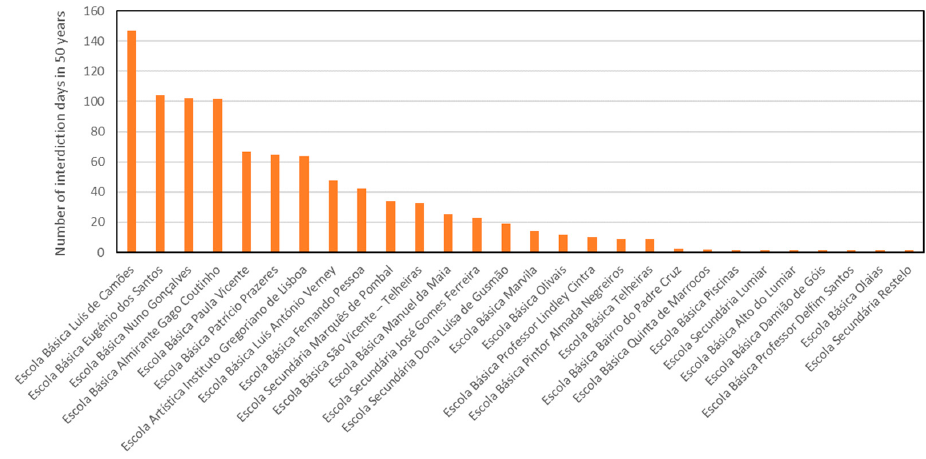
Figure 13. Expected number of interdiction days and “relocated students x month” indicator (SMD).